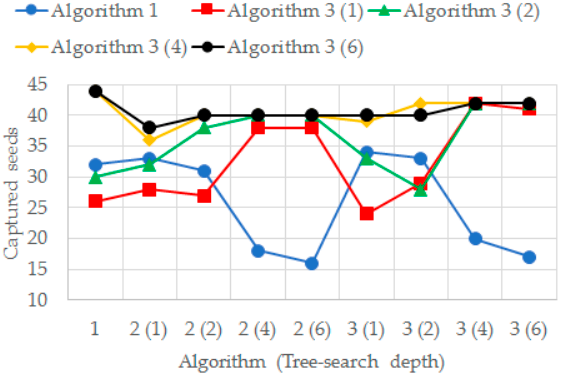
Figure 11. Numbers of seeds captured by Algorithms 1 and 2 when they open the game in the round-robin tournament.